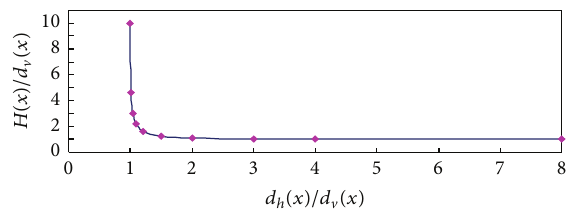
Figure 3: Relationship curve between 𝐻(𝑥)/𝑑 V (𝑥) and 𝑑 ℎ (𝑥)/𝑑 V (𝑥) .